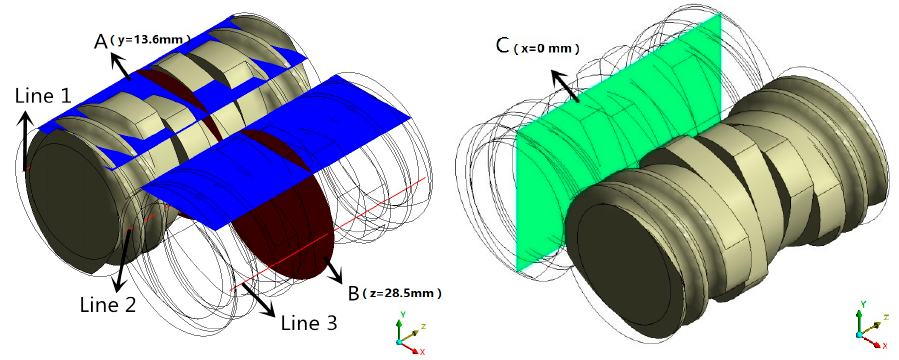
Figure 5. Sketch of sample planes and monitor lines in the TSE.